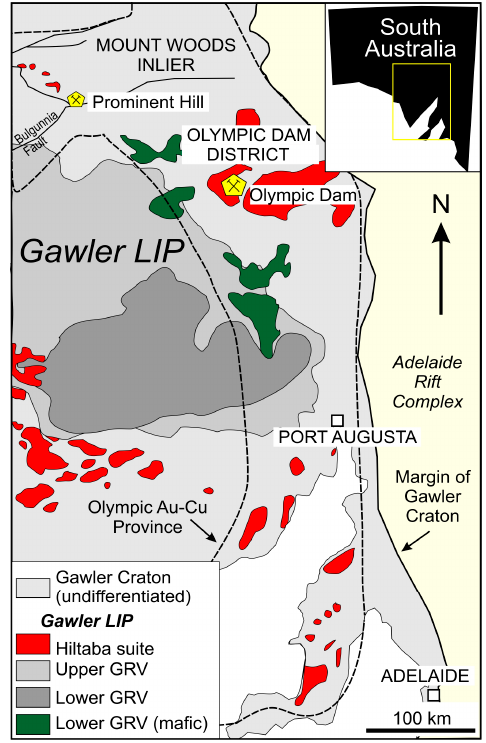
Figure 3. Sketch map showing the location of the Olympic Cu ‑ Au Province within South Australia, as well as exposed Gawler Range Volcanics and Hiltaba Suite intrusive rocks.